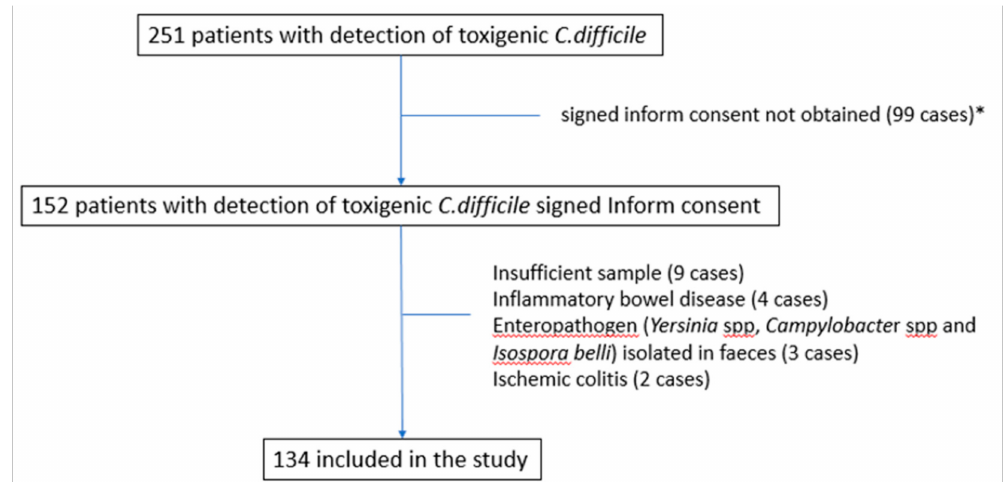
Figure 1. Flow-chart of patients included in the cohort. * Informed consent was not obtained for several reasons (dementia, patient not admitted to the hospital, non-availability of investigation team, short life expectancy, case not attended to by the infectious diseases team,